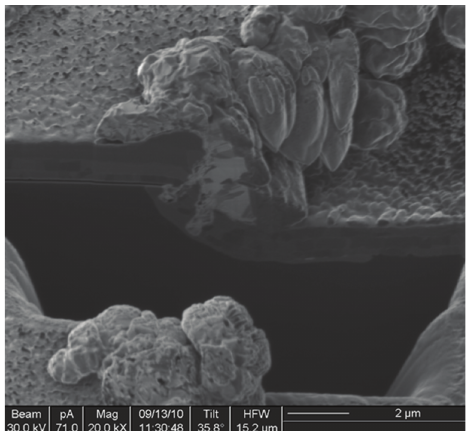
Figure 7: Focused ion beam (FIB) image of the rear of a BA-LIP Ni with LIP Cu test cell. Unwanted Cu plating can be seen at the edges of the rear point